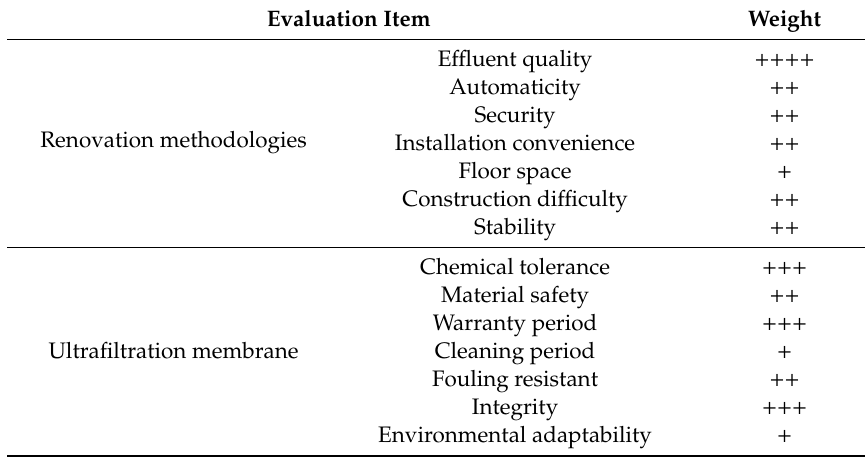
Table 7. Technique indexes of the ultrafiltration membrane system-based WWTP renovation methodology